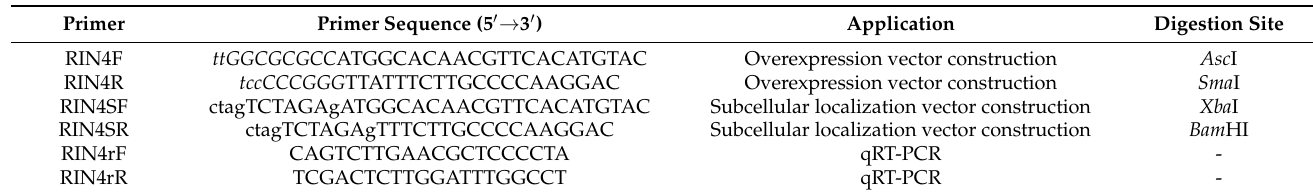
Table 1. Sequence information of primers used in this